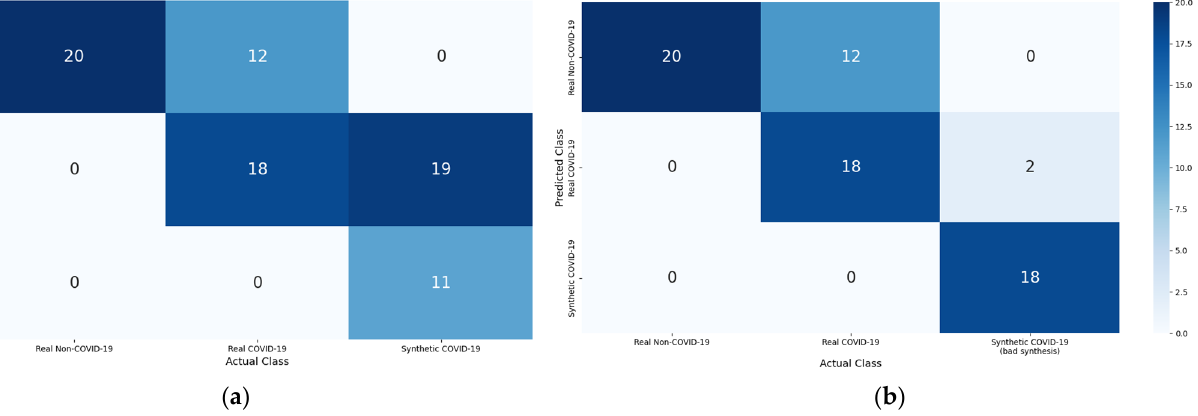
Figure 12. Confusion matrix of the Visual Turing Test: ( a ) 30 images of good image synthesis, ( b ) 20 images of bad image synthesis, compared to real COVID-19 and non-COVID-19 CT images.